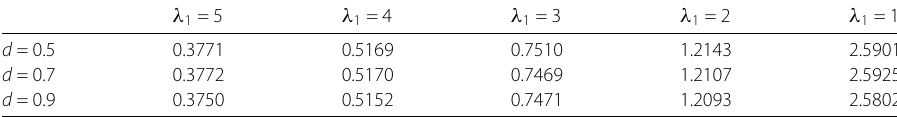
Table 2 Maximal allowable upper bounds τ 1 for different d and λ 1 , when μ = 1.2 λ 1 = 5 λ 1 = 4 λ 1 = 3 λ 1 = 2 λ 1 = 1 d = 0.5